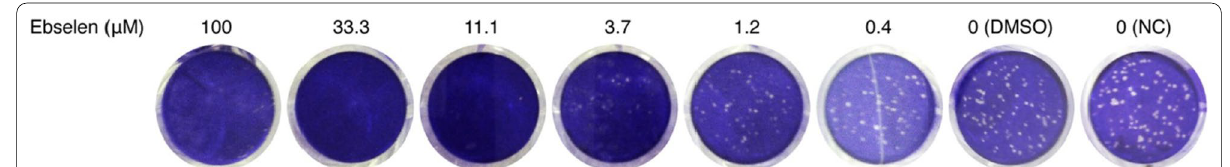
Fig. 4 Covalently bound inhibitors used for the SARS-CoV-2M pro (N3) and the SARS-CoV M pro (N1)